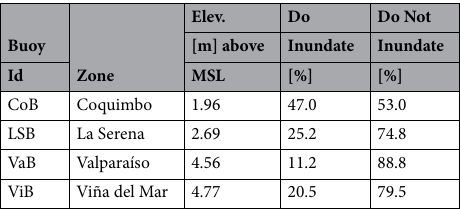
Table 1. Distribution of scenarios that do and do not inundate at each inland numerical